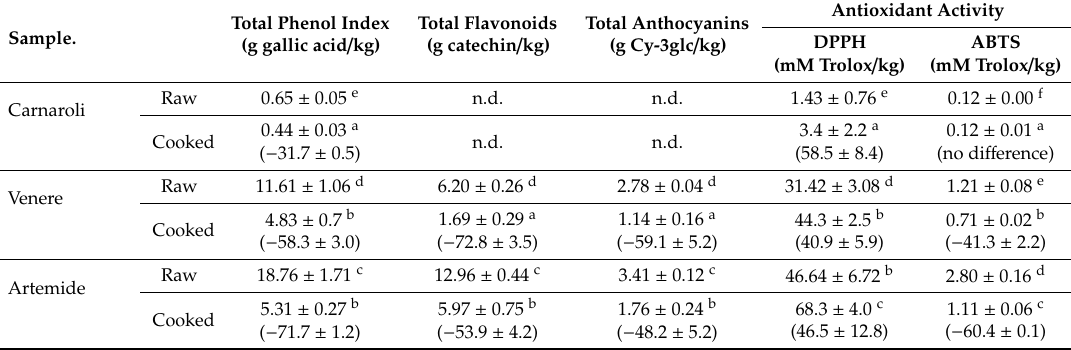
Table 2. Total phenol index, total flavonoids, total anthocyanins and antioxidant capacity of Carnaroli (sample 15), Venere (sample 6) and Artemide (sample 13) rice cultivars, cooked in laboratory conditions. Results are means ± standard deviation of three independent sample preparations. The percentage di ff erences between raw and cooked rice are reported in brackets. Di ff erent letters mean significant di ff erences ( p <